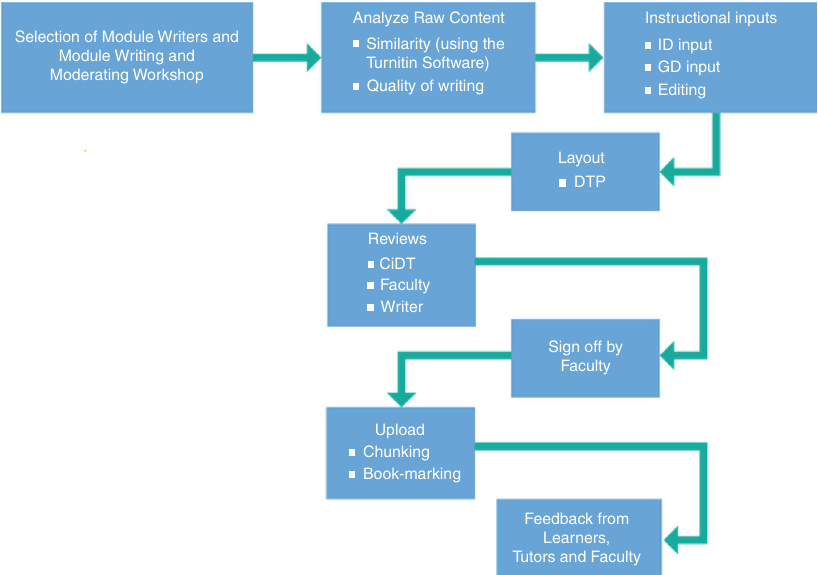
Figure 3. The CiDT